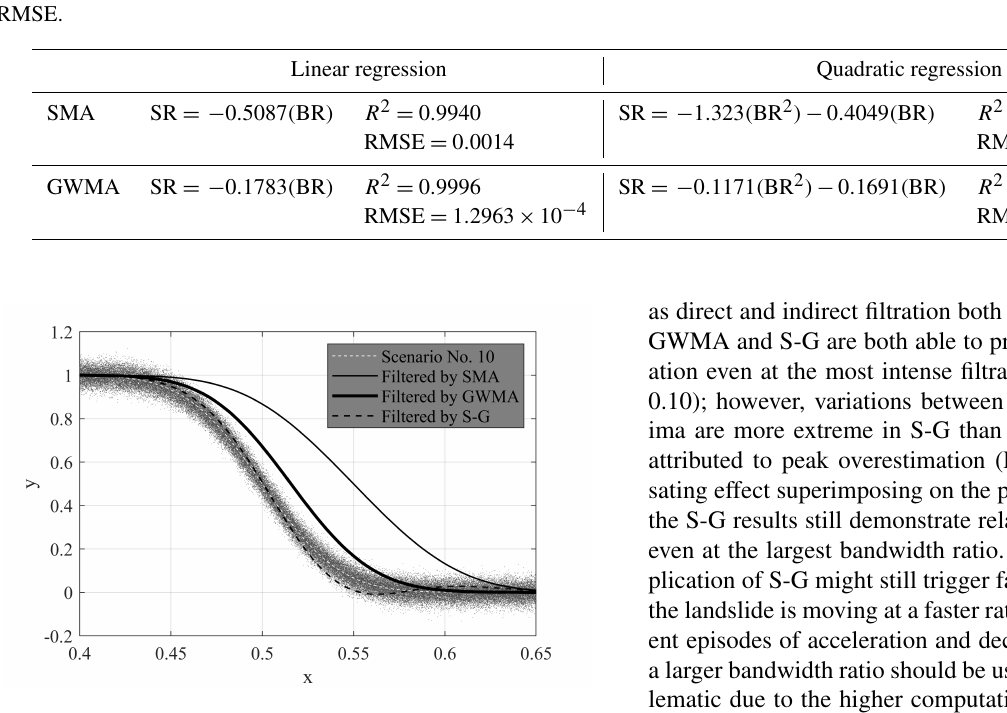
Figure 14. Scenario 10 with and without scatter, as well as with scattered results filtered by SMA, GWMA, and S-G for an n/t value of 0.15 and a bandwidth ratio of